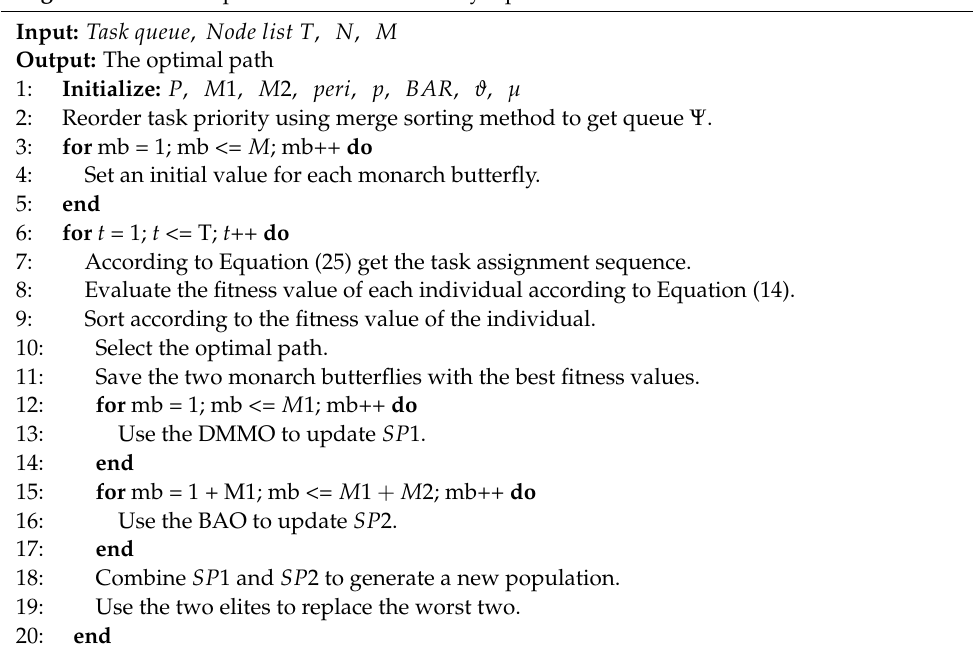
Algorithm 1: The Improved Monarch Butterfly